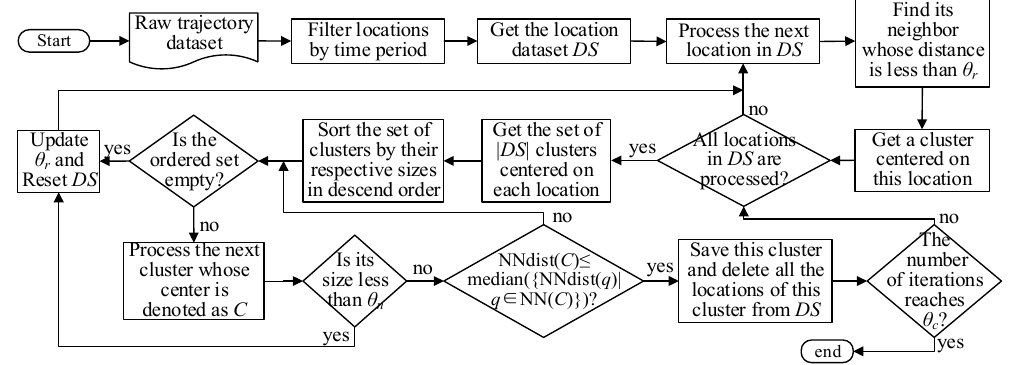
Figure 2. Schematic diagram of the proposed approach.